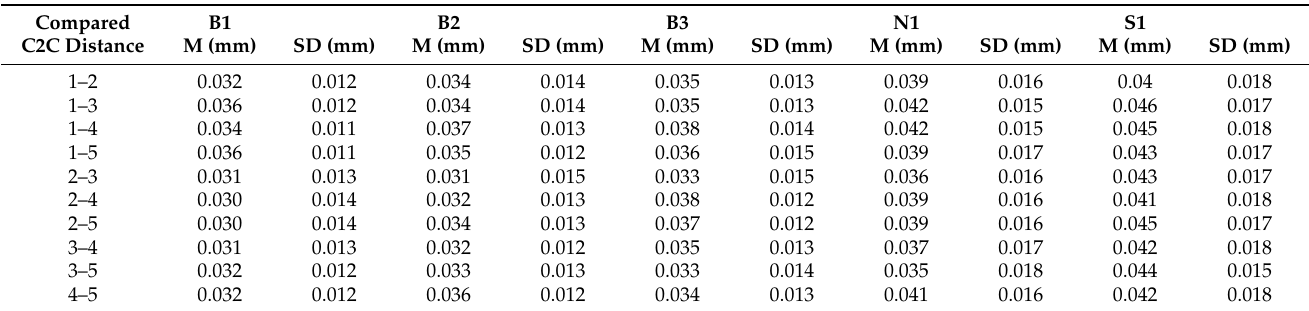
Table 4. Average distances (M) and standard deviations (SD) of C2C absolute distance errors of 3D comparisons, after ICP registration method. Compared